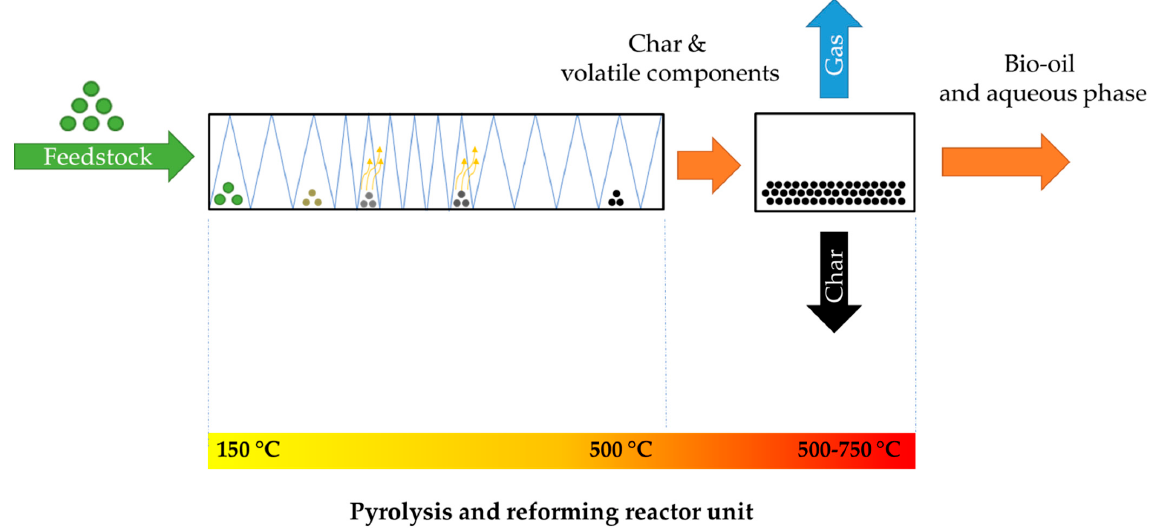
Figure 1. Thermo-catalytic reforming reactor with a partial char loop as a catalyst. Gas, vapours and char are created during the pyrolysis stage. In the second step, the o ff -gases and vapours are upgraded by passing through a bed of char that is continuously removed from the reformer, which results in the production of syngas and oil of a higher quality. The e ffi ciency, quality, and properties of the process’s end products can be con- trolled by adjusting the temperatures used throughout the process. These factors de fi ne how the by-products of the TCR process are utilised going forward. Upgrading allows for easier separation of water from the bio-oil fraction. High-energy syngas with a high con- centration of H 2 and high-quality char can be produced via TCR technology, which is an